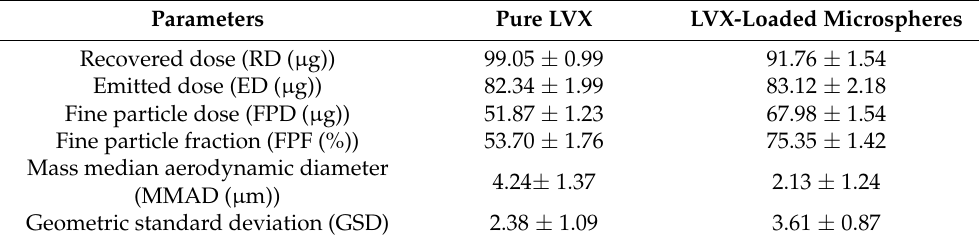
Table 3. Aerodynamic parameters of free LVX and optimized LVX-loaded microspheres.